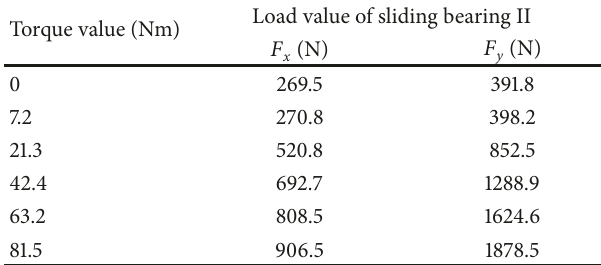
Table 3: Load value of sliding bearing II under constant torque